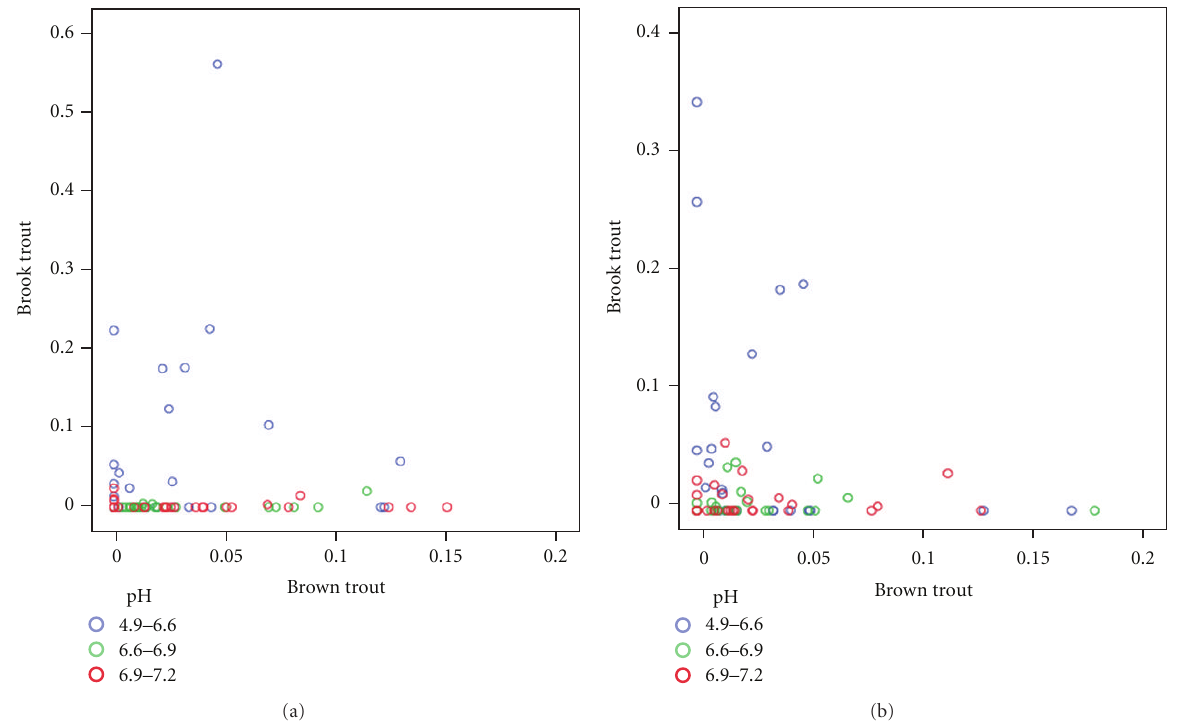
Figure 4: Scatter plots of the relationships between the densities of brook trout and brown trout across the study sites. Study sites are divided in three equal-sized groups of acidity classes. In 1994 (a), one outlier with high densities of both species was excluded. In 2004 (b), two outliers with high densities of both species were